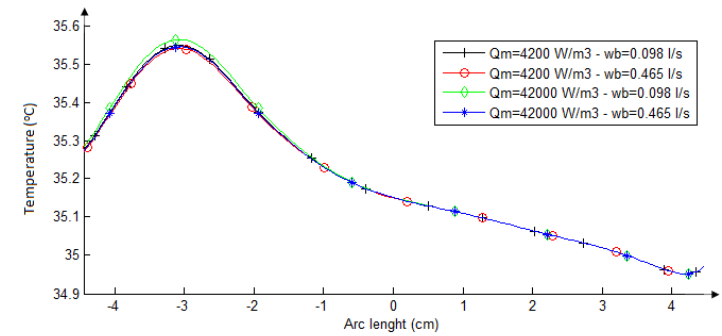
Figure 9. Surface temperatures obtained from the four possible combinations of metabolic heat and blood perfusion values considering no fat tissue and the biggest thyroid